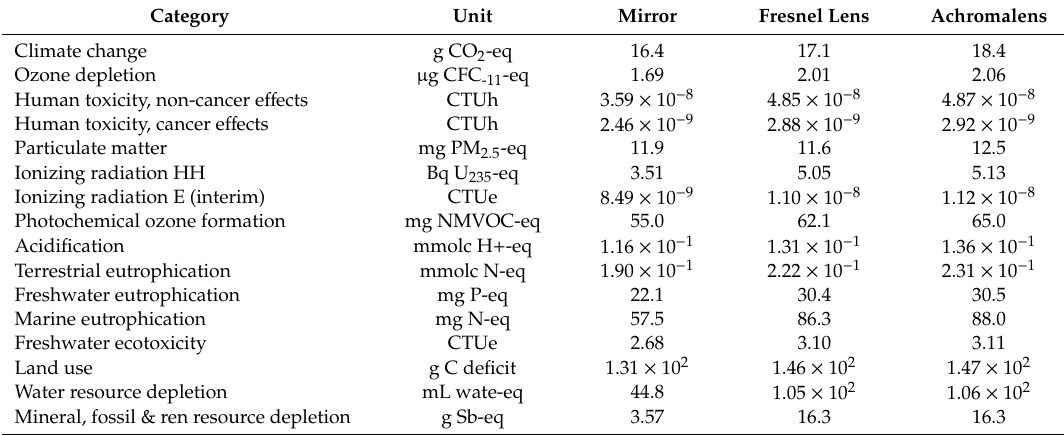
Table A4. Impact assessment results (per kWh).